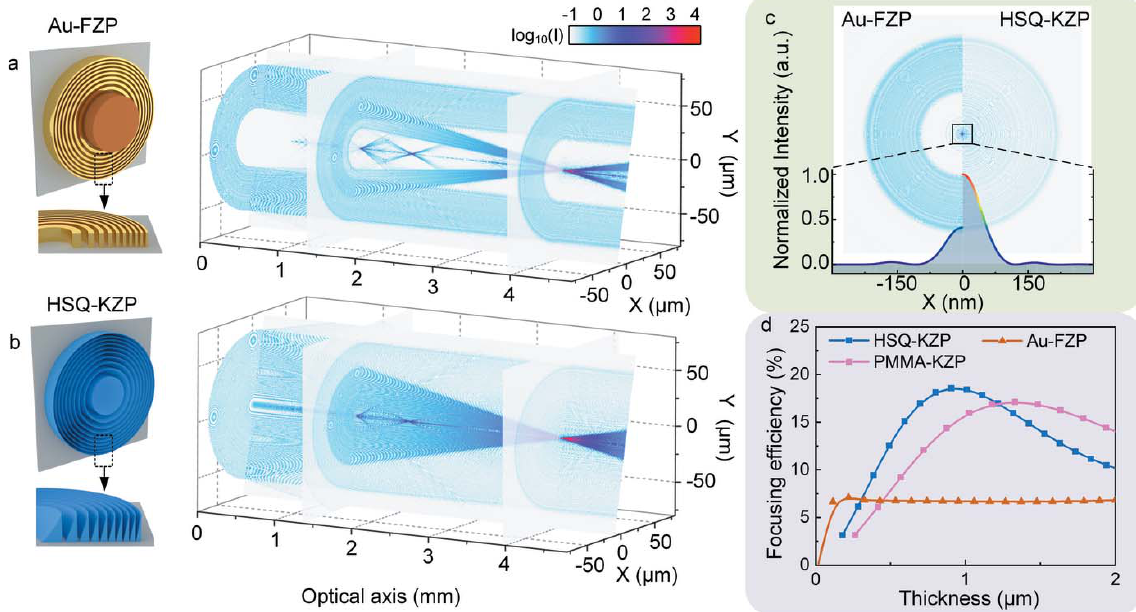
Figure 1 Comparisons of wavefield propagations between the HSQ kinoform zone plate (HSQ-KZP) and the metal zone plate (Au-FZP). The wavefield propagation is calculated using the beam propagation method combined with the quasi-discrete Hankel transform [BPM-QDHT (Tong et al. , 2022)]. The resolution of the Au-FZP ( a ) and the HSQ-KZP ( b ) is 100 nm with a diameter of 100 m m. The thickness of the Au-FZP and HSQ-KZP is 250 nm and 750 nm, respectively. The diameter of the beamstop for the FZP is 50 m m. ( c ) Comparison of point-spread functions of the focused light by both the Au- FZP and the HSQ-KZP, respectively, at the focal plane. ( d ) The calculated focusing efficiencies of the Au-FZP, HSQ-KZP and PMMA-KZP for soft X-rays (500 eV) using the BPM-QDHT